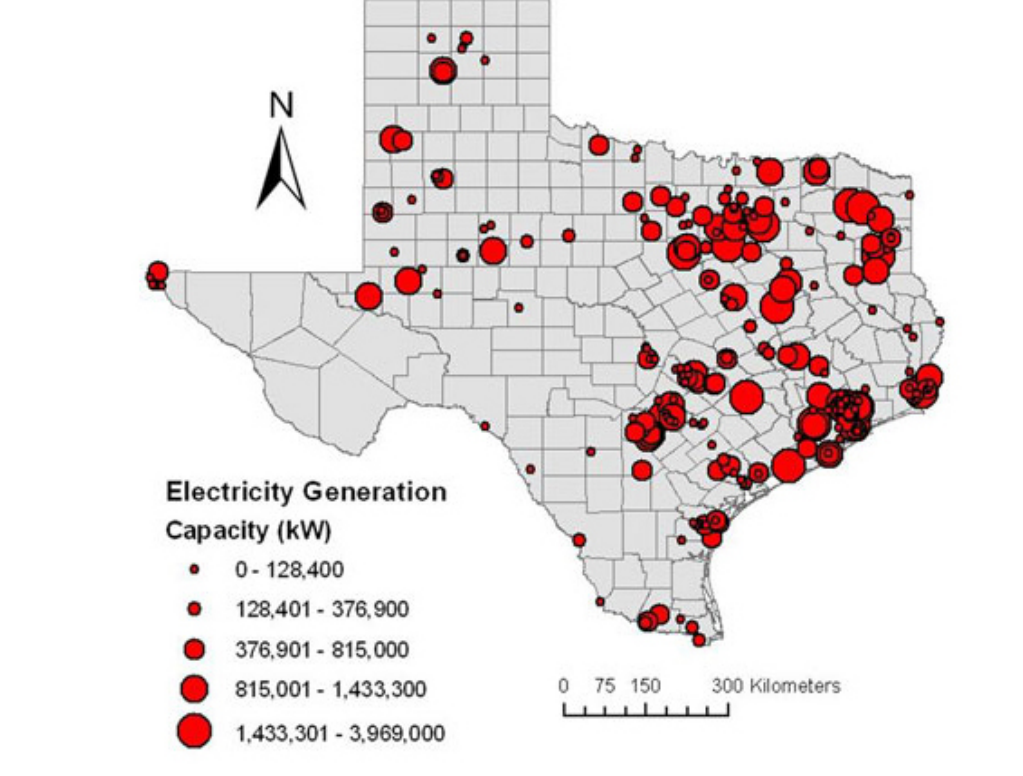
Fig. 3 . Electricity generation capacity (kilowatts [kW]) from Texas power plants (King et al.